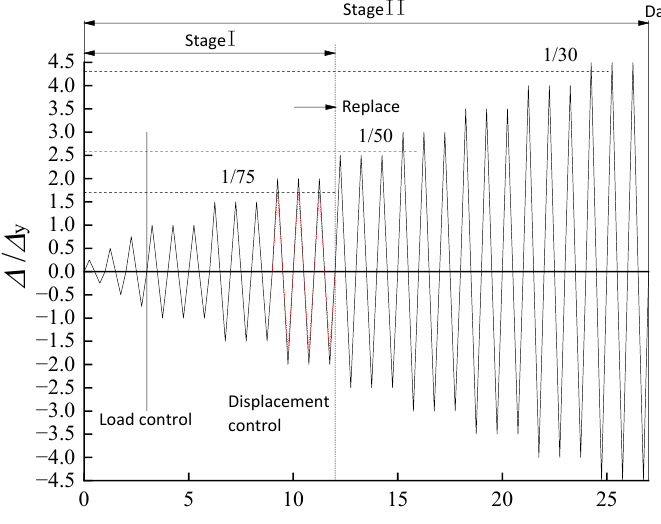
Figure 6. Loading Figure 6. Loading protocols.